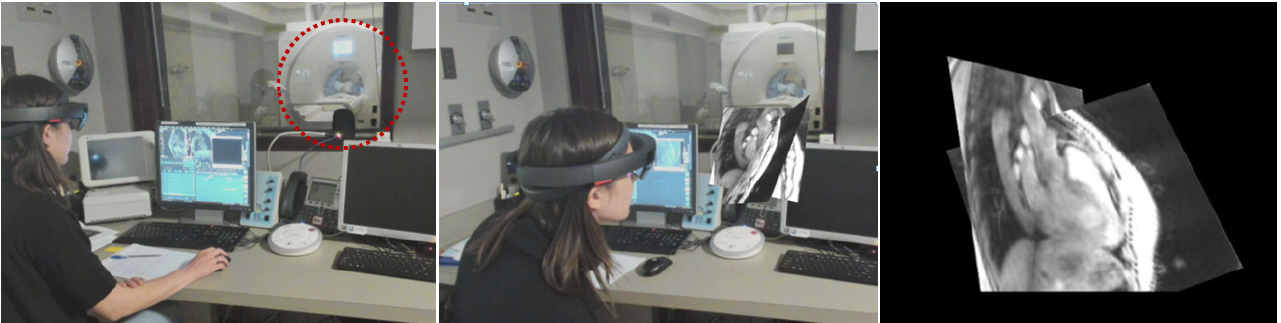
Figure 5. Operation of the full system at the MR scanner. ( Left ) A user wearing a mixed-reality headset sits at the scanner control computer before scanning a healthy volunteer lying in the scanner bore (red dashed circle). ( Middle ) During the scan, the user sees a multi-slice rendering of the volunteer’s heart in real-time. ( Right ) User’s view of the rendering. Note that what appears black in the image appears transparent to the user; the user sees the rendering within the natural environment. A video version of this figure is available in the Supplementary